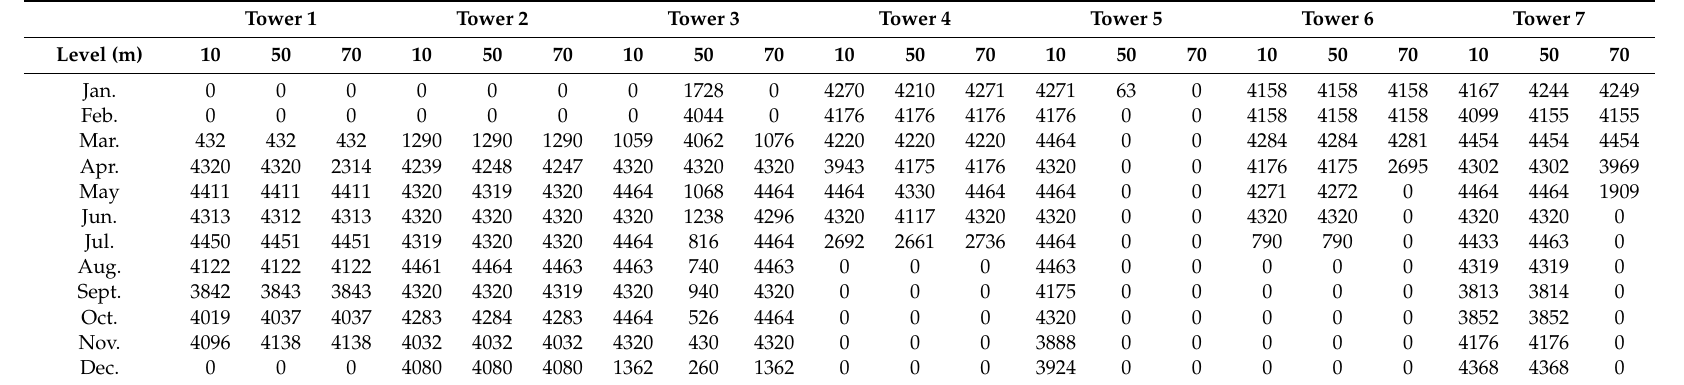
Table 4. The number of wind speed observations after quality